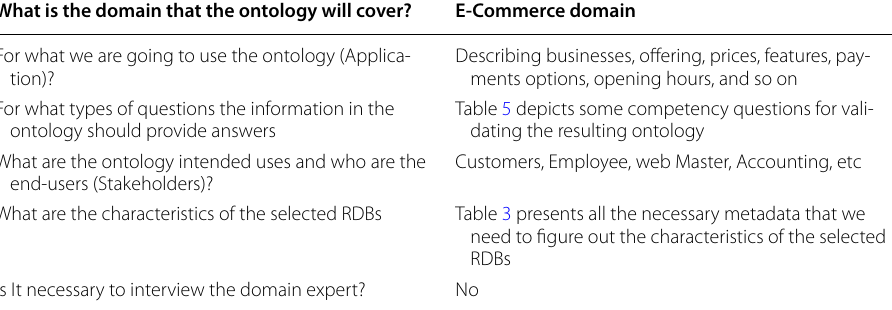
Table 4 The list of questions the ontologist must answer before start building ontology What is the domain that the ontology will cover?